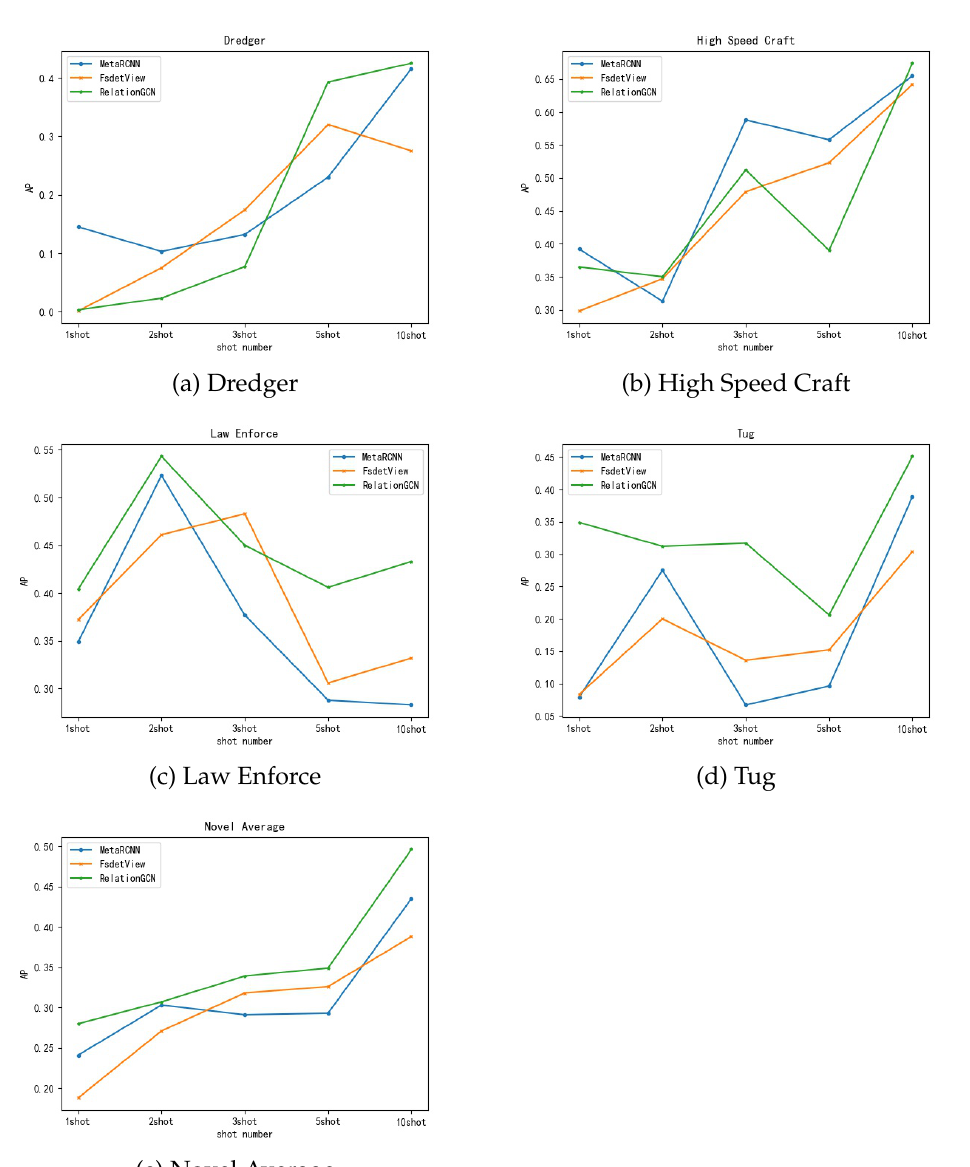
Figure 11. Comparison of precision on each novel class and average